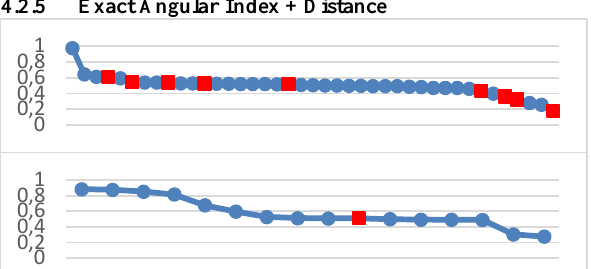
Figure 6: EAI + Distance Scores for a simple (top) and a complex (bottom)